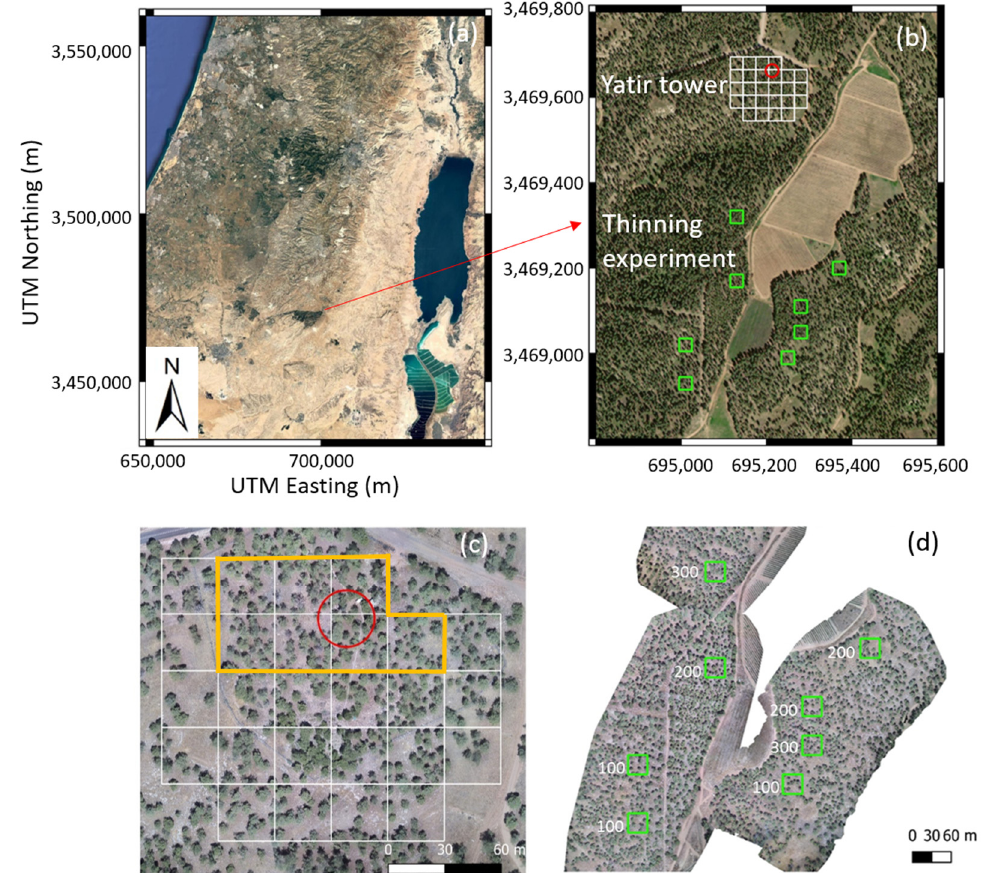
Figure 1. ( a ) The location of the Yatir forest between the Mediterranean Sea and the Dead Sea in southern Israel. ( b ) The Yatir flux tower site and thinning experimental plots in UTM zone 36R. ( c ) The Yatir tower area on the UAV RGB image for 31 July 2019. The circle represents the tower Skye radiometer footprint (15 m radius). The squares represent the Landsat 8 pixels (30 × 30 m; 26 pixels), based on their center coordinates that were extracted from the georeferenced Landsat 8 images. The pixels inside the yellow polygon were used to compare Landsat 8 and tower Skye and analyze the fractional contributions of canopy, soil, and shade. The pixels outside the polygon were used to validate the canopy NDVI retrieval approach. ( d ) Landsat 8 pixels in the thinning plots, with numbers indicating stand densities of 100, 200, and 300 trees per hectare.